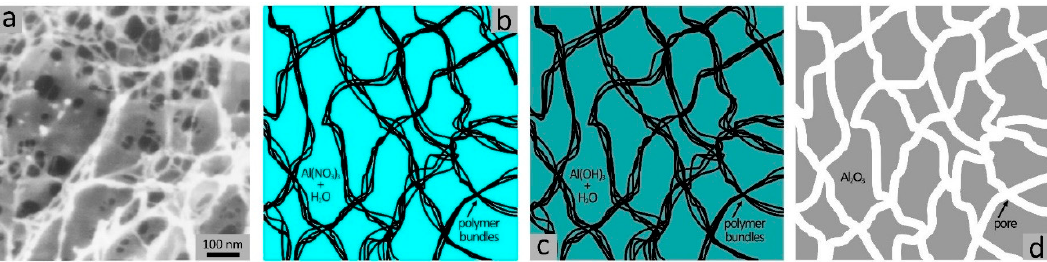
Figure 3. Schematic of the synthesis of mesoporous Al 2 O 3 by using a dimethylacrylamide-based hydrogel as a porogenic matrix; ( a ) FESEM image of a hydrogel (shrunken state), ( b ) bundles of polymer strains in Al(NO 3 ) 3 solution, ( c ) after treatment with ammonia, and ( d ) after thermal decomposition of the polymer. Reprinted with permission from [49], Copyright 2014 Springer Nature.